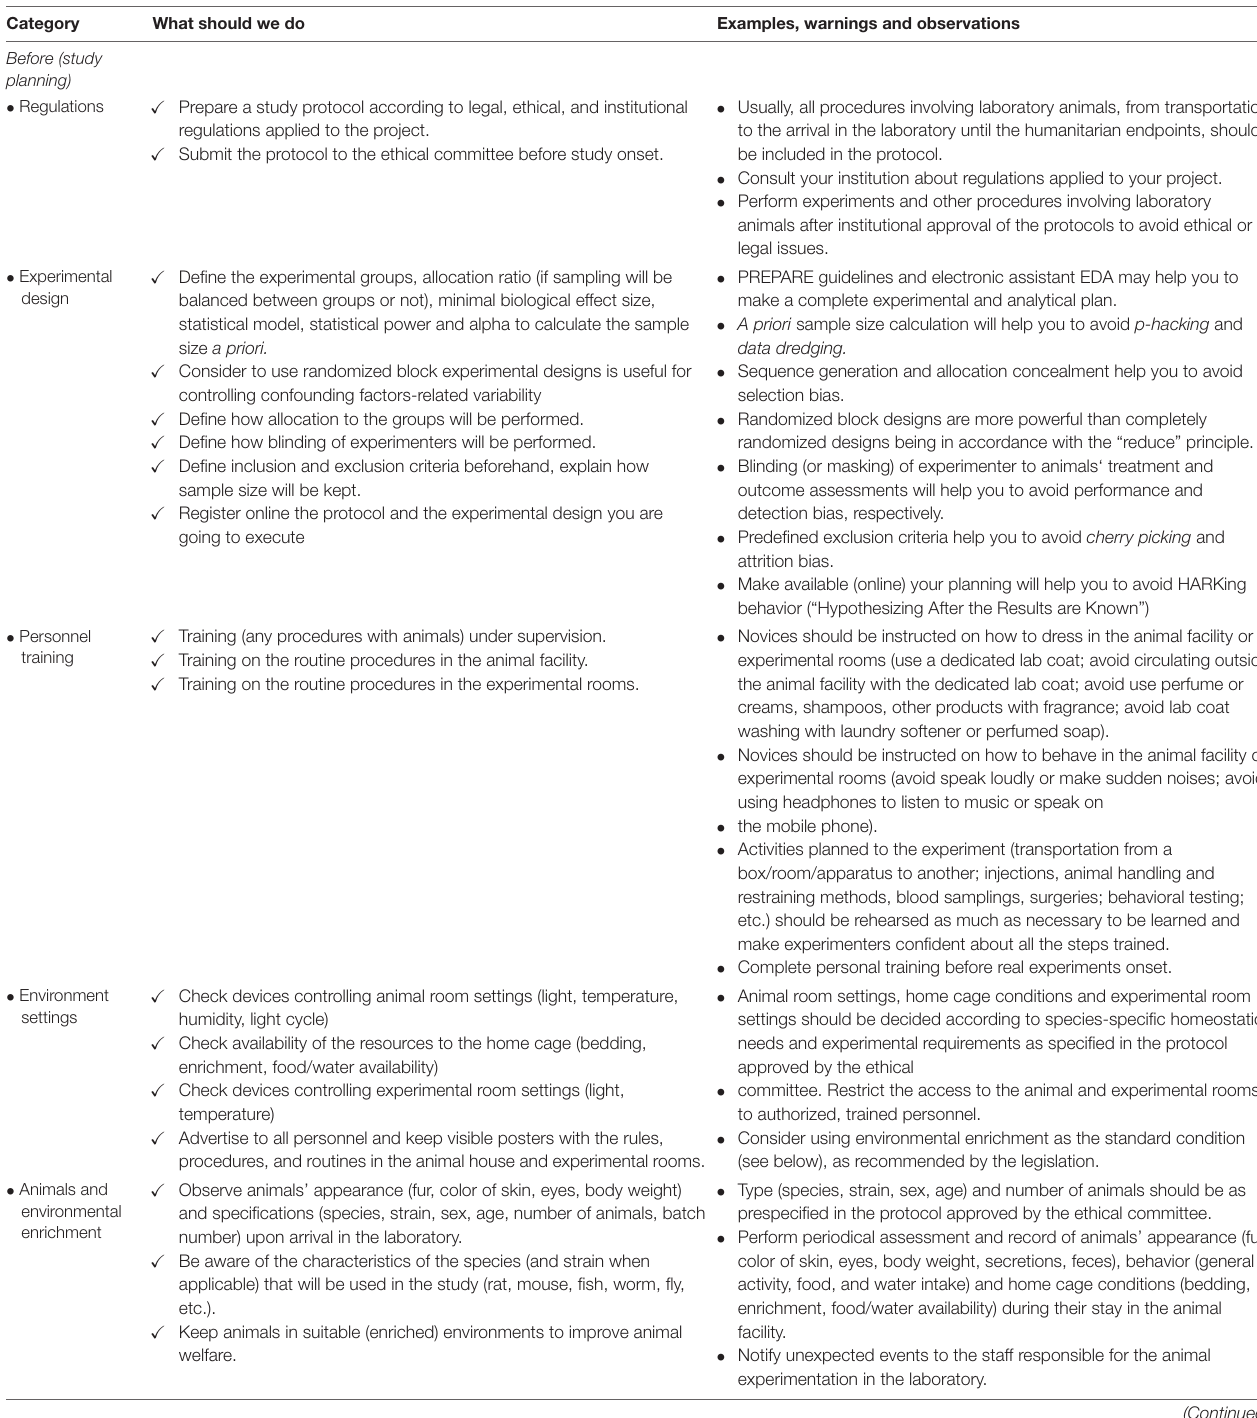
TABLE 1 | Practical tips combining animal welfare and experimental rigor to improve reproducibility in behavioral